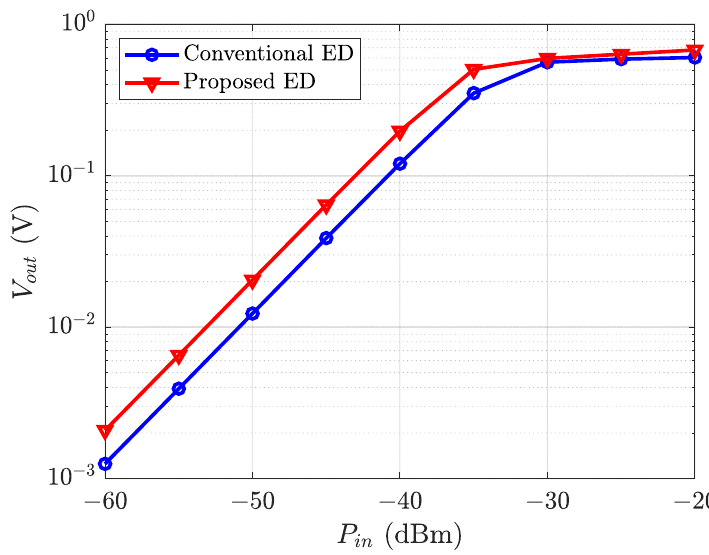
Figure 3. Proposed LC - CL balun-based Gm-boosting RF envelope detector.